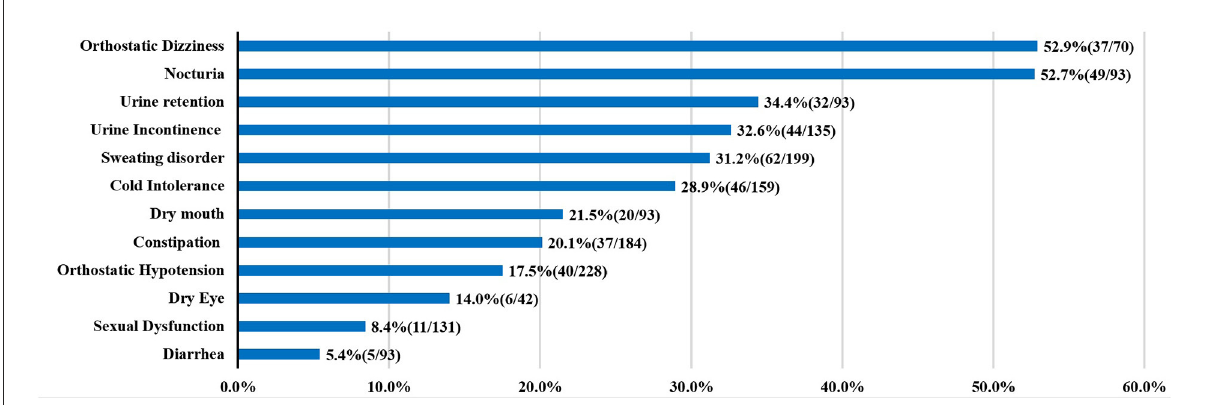
FIGURE2 Autonomic dysfunctions of SCA3. For each clinical manifestation of autonomic dysfunction, the proportion of patients is indicated.